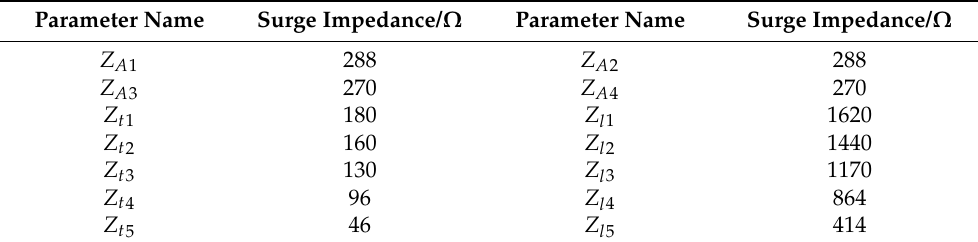
Table 4. Parameters for six segments of the nominal height.